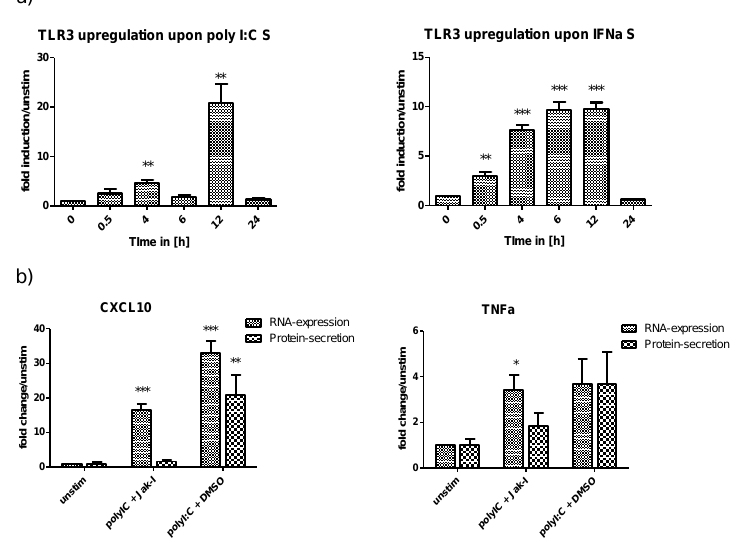
Figure 4. Upregulation of TLR3 expression and function under inflammatory conditions. ( a ) The viral ligand polyI:C induces upregulation of TLR3 mRNA. Medium was supplemented with polyI:C or IFN- α to mimic an inflammatory environment; TLR3 mRNA was measured by qPCR at di ff erent times after stimulation. TLR3 mRNA was significantly upregulated in a time-dependent manner when the cells were stimulated with IFN- α or polyI:C. While IFN- α treatment induced a gradual upregulation of TLR3 mRNA, which peaked at 12 h post-stimulation, polyI:C induced TLR3 mRNA abruptly raised levels at 12 h ( N = 3). ( b ) Gene and protein expression of CXCL10 and TNF- α in polyI:C stimulated cells in the presence of Jak-I. Cells were pretreated with 10 µ M Jak-I or vehicle control DMSO for 1 h. The medium was replaced with polyI:C containing medium with either Jak-I or vehicle control and the cells were cultured for a further 16 h before mRNA and protein levels of CXCL10 and TNF- α were measured by qPCR and ELISA, respectively. Despite inhibition of Janus kinase / signal transducer and activator of transcription (JAK / STAT) signalling by Jak-I, polyI:C stimulated cells showed significant induction of CXCL10 and TNF- α gene-expression, indicating that polyI:C-detection by TLR3 and associated nuclear factor kappa-light-chain-enhancer of activated B cells (NF-kB) signalling plays a role in initiating anti-viral innate immune responses ( N = 3). It has to be noted that the potent induction of CXCL10 mRNA in Jak-I treated cells is in part owing to the IFN-independent induction of CXCL10 expression [27–29], indicating that TNF- α is the more reliable readout. Results are shown as mean +/ − SEM. * p < 0.05, ** p < 0.01, and *** p < 0.001. TLR = toll-like receptor, S = stimulation, IFN = interferon, CXCL10 = C-X-C motif chemokine 10, TNF = tumor necrosis factor alpha, DMSO =